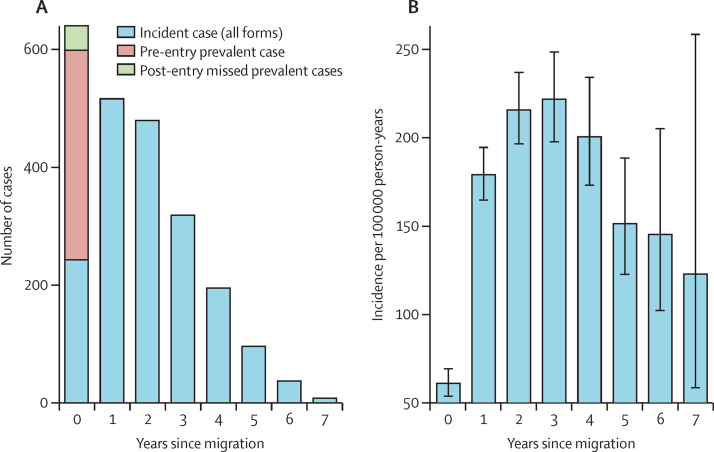
Cases of tuberculosis notified in migrants to England, Wales, and Northern Ireland (A), and incidence rates for tuberculosis (B), by time since entry(A) Includes 439 pre-entry prevalent cases detected between Jan 1, 2006, and Dec 31, 2012, post-entry missed prevalent cases (41 cases notified within 90 days after migration), and all tuberculosis cases (1873 cases) notified in the UK among migrants by year since migration. The error bars in (B) are 95% CIs.